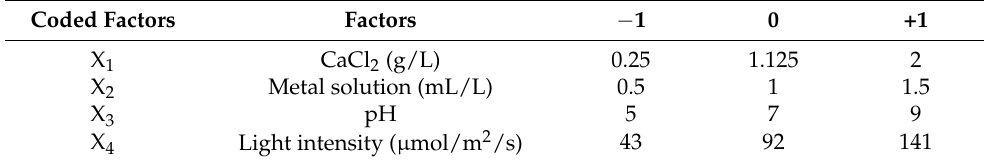
Table 3. Variables and experimental levels for optimizing culture